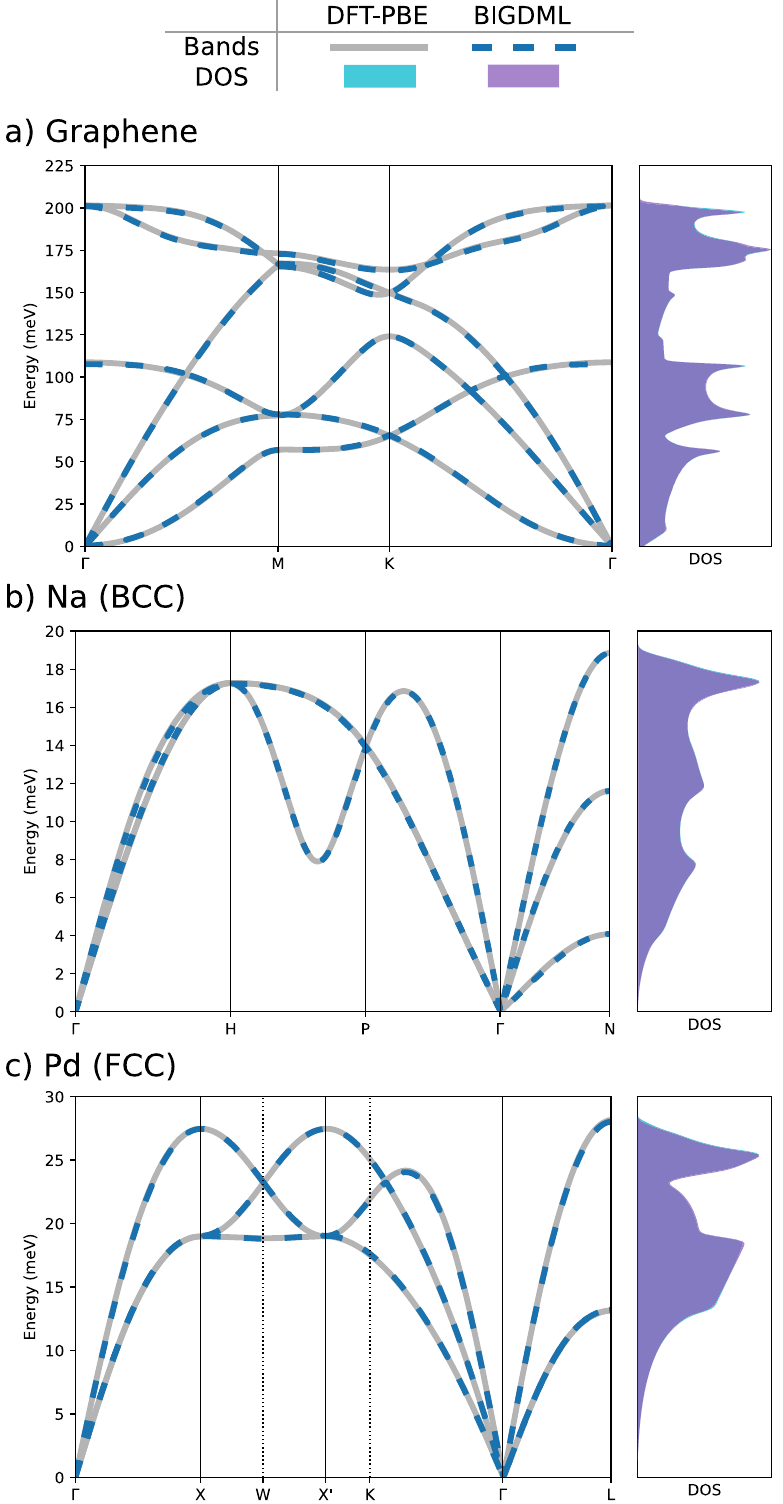
Fig. 6 Model performance on phonon bands reconstruction. Phonon spectra (left panels) and vibrational densities of states (right panels) for ( a ) graphene, ( b ) bulk sodium, and ( c ) bulk palladium along the high-symmetry paths in their respective Brillouin zones. The dashed line represents BIGDML and the continuous line the reference DFT-PBE level of theory. The differences between DFT and BIGDML are visually